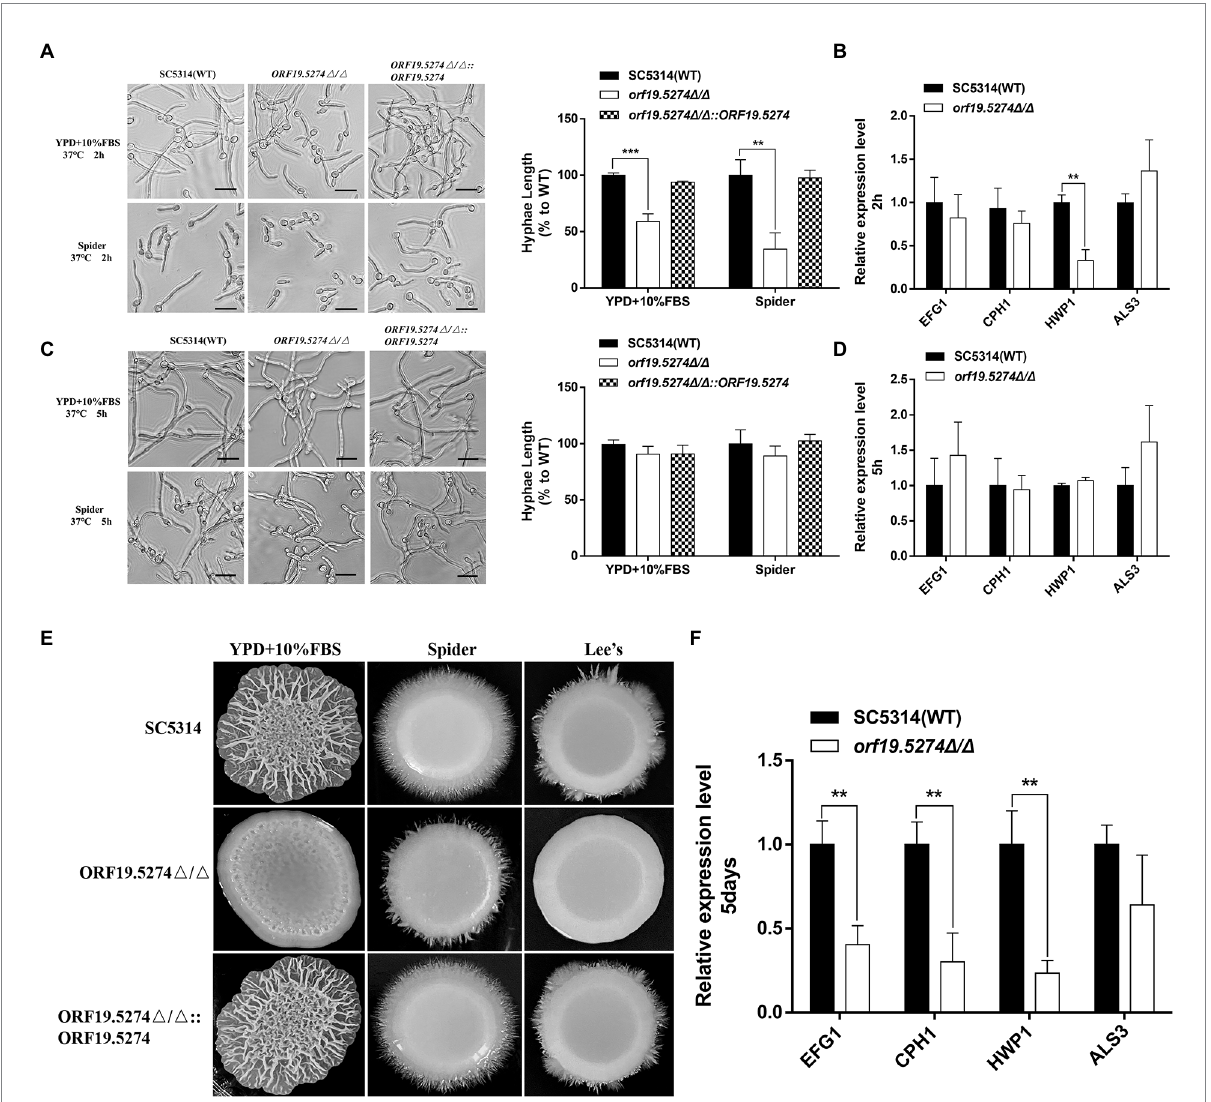
FIGURE 5 Morphological switching ability of C. albicans under filament-inducing conditions. (A) Cells were incubated in liquid YPD + 10%FBS serum and Spider medium for 2 h at 37 ° C. The samples were examined and photographed by light microscopy. Hyphae lengths in the wild-type, orf19.5274 Δ / Δ , orf19.5274 Δ / Δ ::ORF19.5274 strains were measured by a measurement tool in OlyVIA version 3.3. (B) After 2 h of incubation in the liquid inducing medium of Spider, cells were harvested and used for RNA isolation. Quantitative expression levels were determined by